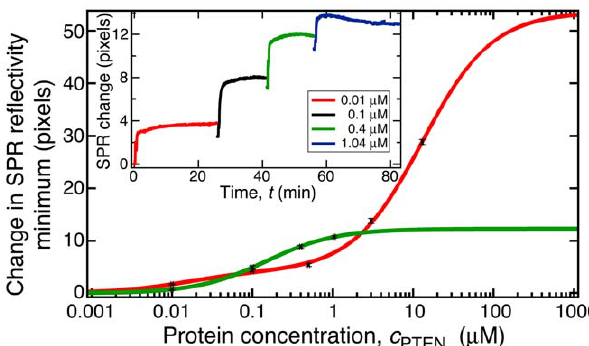
Figure 1. Quantification of PTEN Binding to stBLMs by Surface Plasmon Resonance. Exemplary SPR results showing a raw data set (binding of wt PTEN to an stBLM composed of DOPC and , 2 mol% PI(4,5)P 2 ; inset) and two binding isotherms (main panel). The green isotherms shows a fit to the data in the inset, which are well described by assuming a simple Langmuir adsorption (Eq. 1) with K d , 300 nM. In distinction, the isotherm shown in red (binding of wt PTEN to an stBLM composed of DOPC, , 28 mol% DOPS and , 2 mol% PI(4,5)P 2 with chol) shows bimodal binding behavior of the protein to the two anionic components in the bilayer in which one component has a K d of , 40 nM and the second has a K d of , 10 m M. While the first of these values is smaller than the K d of PTEN binding to PI(4,5)P 2 alone (see cross-over of the two curves in the low-concentration regime), the second K d coincides approximately with that measured for wt PTEN binding to stBLMs that contain only DOPS as a single anionic component. A conversion of the raw data into equivalent protein mass per unit area is given in Information